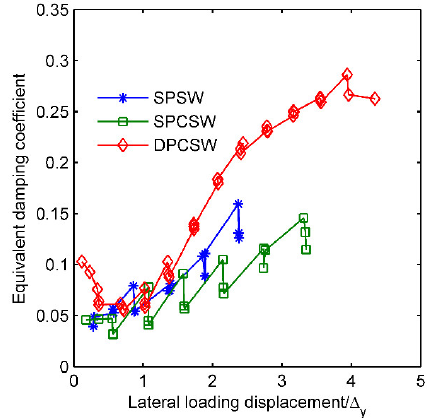
Figure 17. Energy dissipation capacity of specimens.